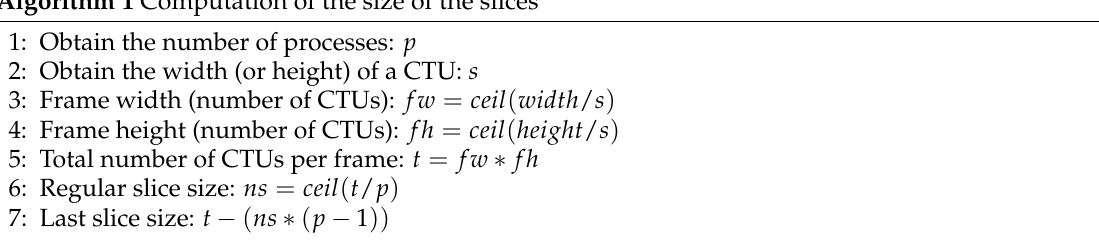
Algorithm 1 Computation of the size of the